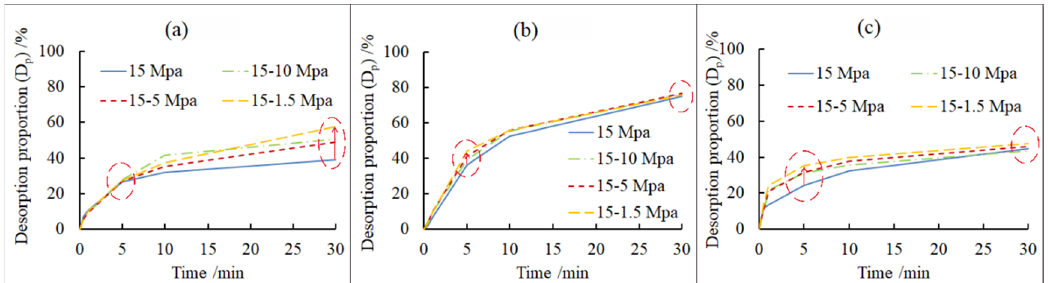
Figure 11. The changes of desorption proportions ( D p ) when effective stress reduction in the first 30 min: ( a ) is the PUC sample; ( b ) is the BDC sample; ( c ) is the DDC sample.